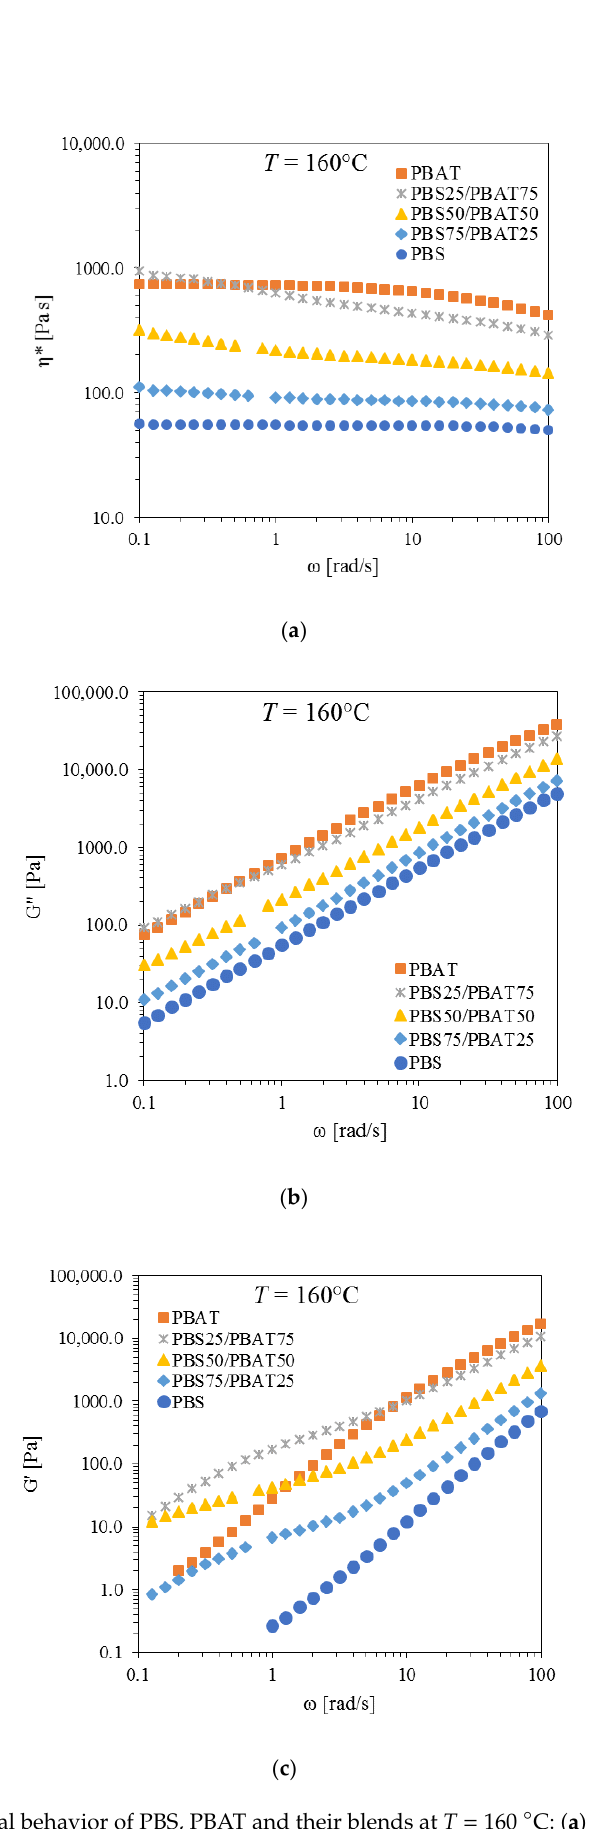
Figure 2. Rheological behavior of PBS, PBAT and their blends at T = 160 °C: ( a ) complex viscosity, η*, ( b ) loss modulus, G ’’, and ( c ) storage modulus, G ’. ( b ) loss modulus, G ”, and ( c ) storage modulus, G